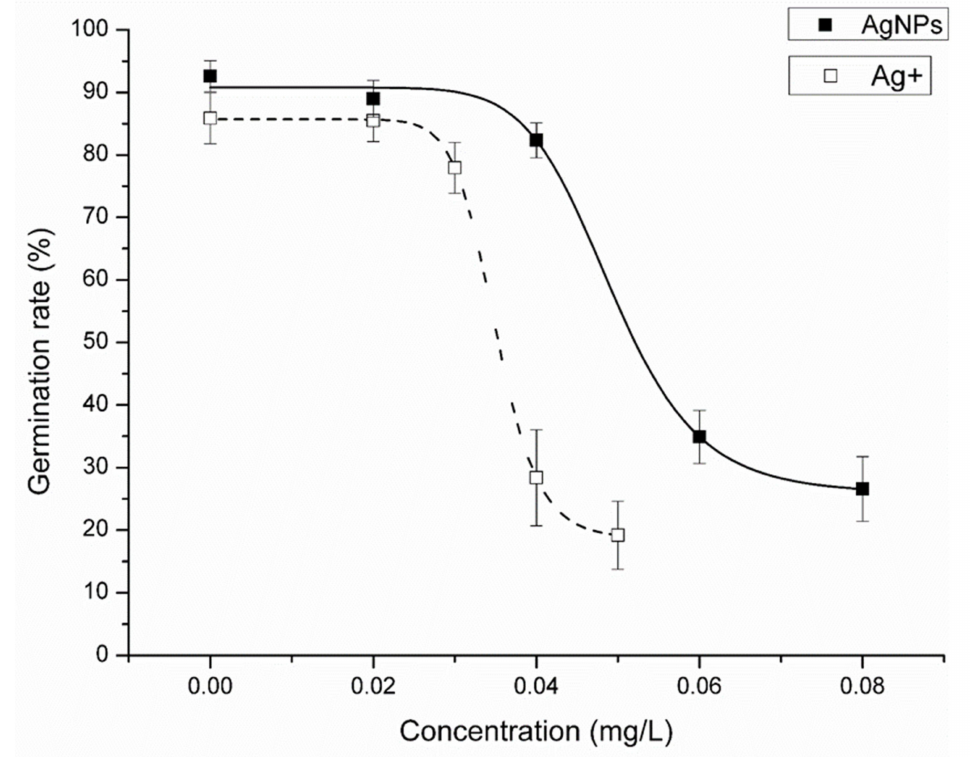
Figure 5. Concentration courses of effect of AgNPs and Ag + on the spore germination rate of Ceratopteris thalictroides after 17 d exposure. Data represent the mean ± SD ( n =